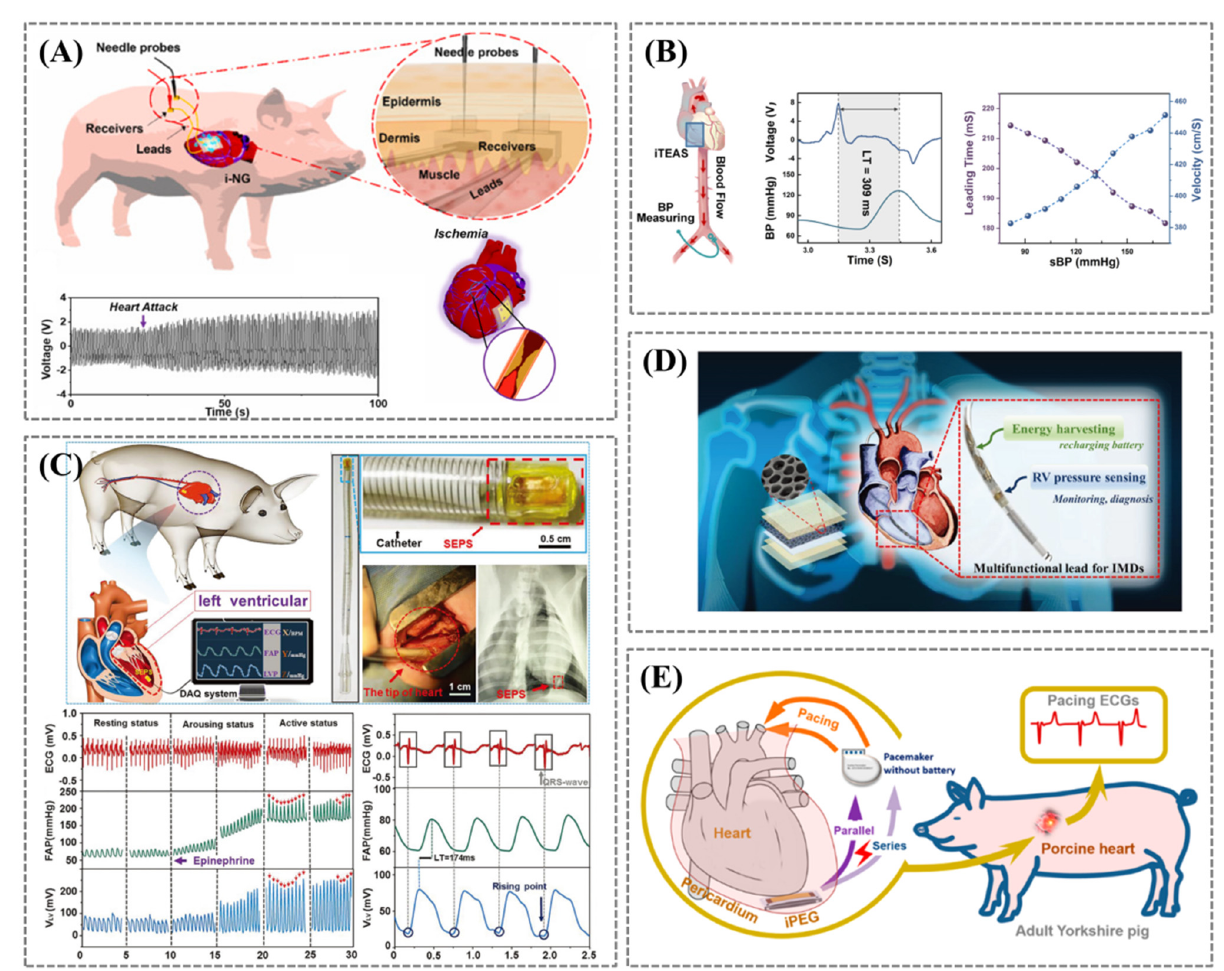
Figure 6. ( A ) Schematic of the i − NG system placed in pig, showing the voltage output during normal heartbeat and heart attack by blocking the coronary arteries causing ischemia. Reprinted/adapted with permission from Ref. [68]. ( B ) Schematic diagram of the mechanism for monitoring blood flow velocity by iTEAS. The red arrows indicate the direction of blood flow. Reprinted/adapted with permission from Ref. [69]. ( C ) The comparison of working signals from ECG, FAP, and SEPS in different states and the SEPS implanted into an Adult Yorkshire swine’s heart via minimally invasive surgery. Reprinted/adapted with permission from Ref. [67]. ( D ) Diagram showing a multifunctional pacemaker lead that combines energy harvesting and sensing strategies. Reprinted/adapted with permission from Ref. [70]. ( E ) Schematic illustration of the implantable piezoelectric generator (iPEG). Reprinted/adapted with permission from Ref. [71].